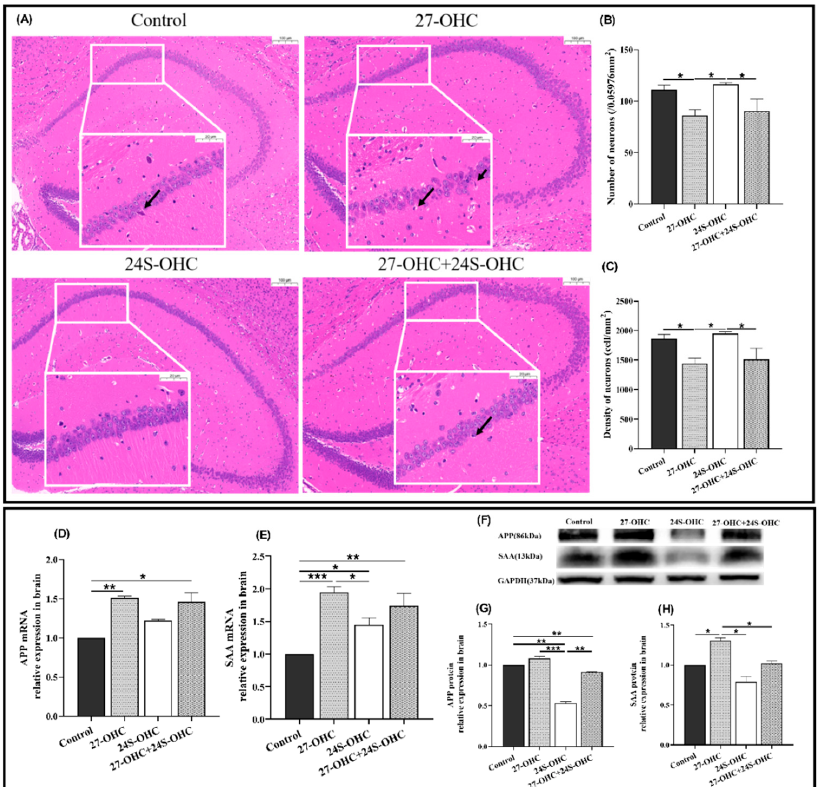
Figure 3. Effects of oxysterols on brain pathology and the expression of amyloid precursor protein in the brain. ( A ) HE staining of the whole brain ( n = 3, scale bar: 100 and 20 µ m), black arrows: Nuclei pyknosis; ( B ) number of neurons (/0.05976 mm 2 ) ( n = 3, mean ± SEM); ( C ) density of neurons (cell/mm 2 ) ( n = 3, mean ± SEM); ( D ) APP mRNA ( n = 7, median with range); ( E ) SAA mRNA ( n = 7, mean ± SEM); ( F ) Western blot results of APP and SAA; ( G ) APP protein ( n = 7, mean ± SEM); ( H ) SAA protein ( n = 7, mean ± SEM). *: p < 0.05, **: p < 0.01, ***: p <